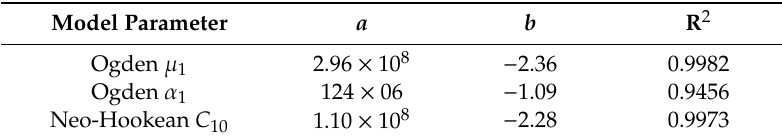
Table 3. Material constants a and b for the power equation denoting the correlation between temperature and Ogden and Neo-Hookean parameters. The correlation coefficient (R 2 ) is between computed model parameters and the power equation.